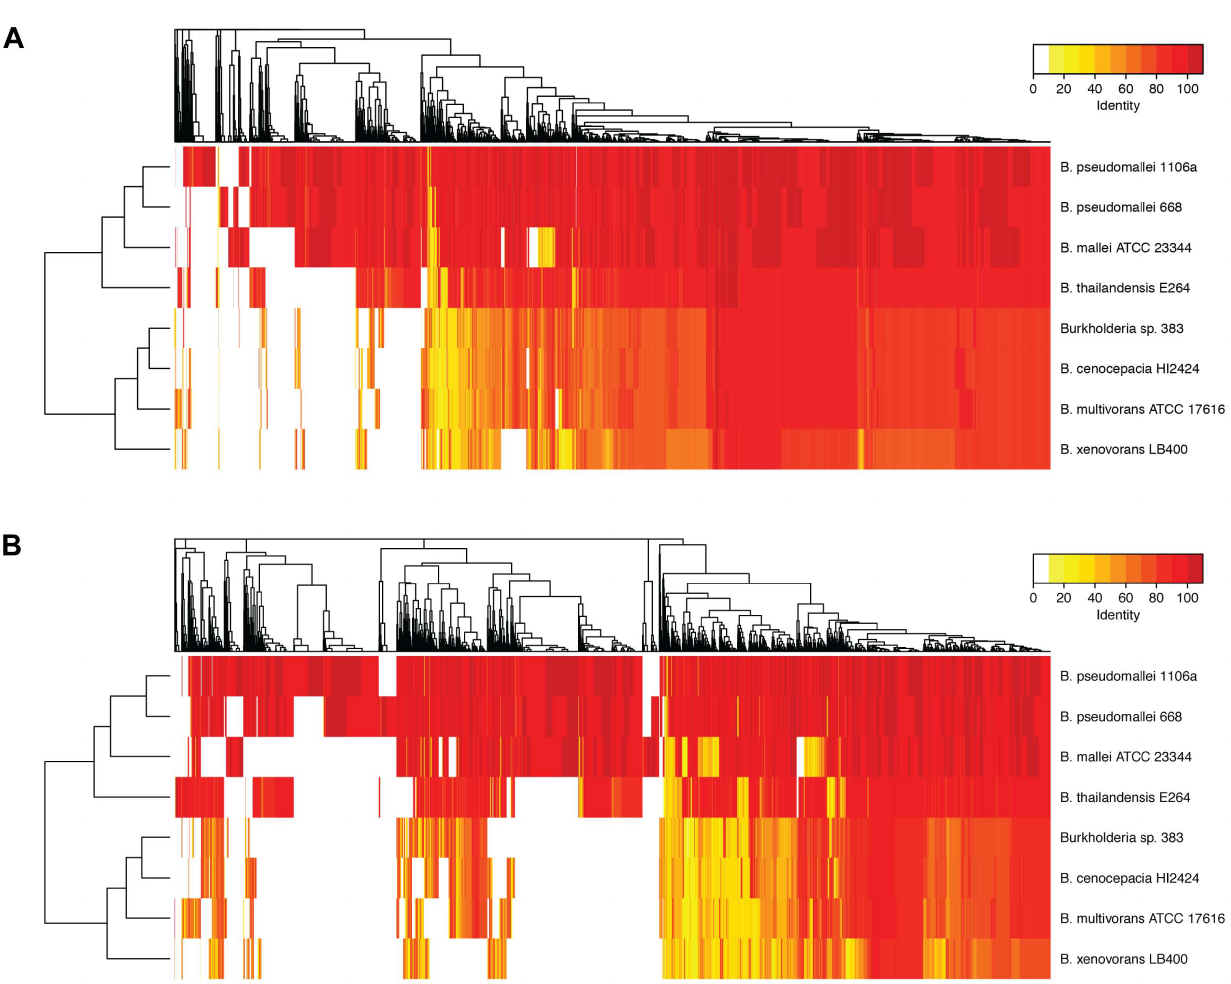
Fig. 3. Heatmap displaying best BLAST hits of protein sequences from eight Burkholderia genomes to B. pseudomallei K96243 proteins on chromosome 1 (Panel A) and chromosome 2 (panel B). The protein BLAST was run without the filter and an E-value cutoff of 1e-15.